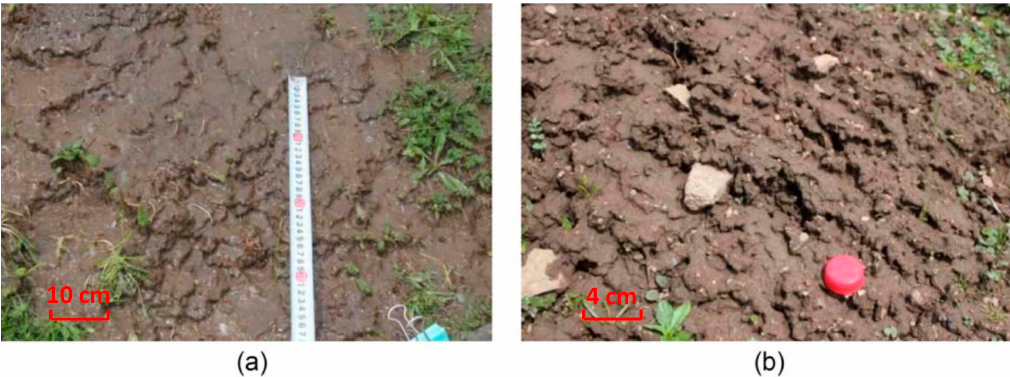
Figure 6. Evolving surface texture of the mound surface during and after the rainfall experiment (( a ) 10 min into the rain event, ( b ) At the end of the rain event).